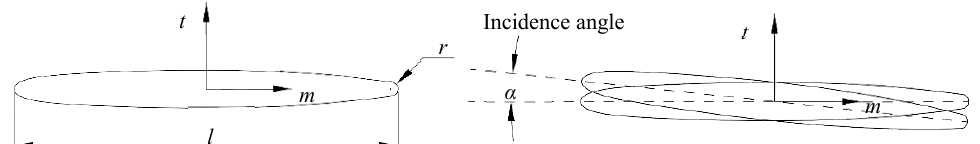
Figure 1. Hydrofoil model and its parameters.